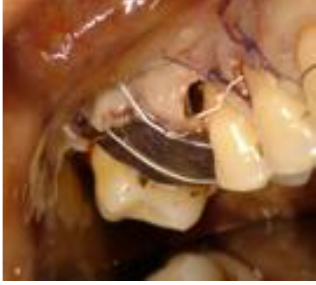
Figure 7. Detail of the sutures: resorbable for the release incisions and in PTFE to keep the flap close to the barrier.